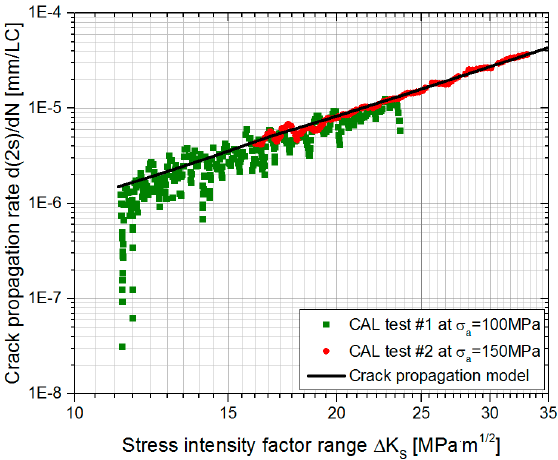
Figure 3. Results of CAL test #2 at load of σ a = 150 MPa ( a ) surface crack length vs. load-cycles; ( b ) crack propagation rate vs. stress intensity factor.